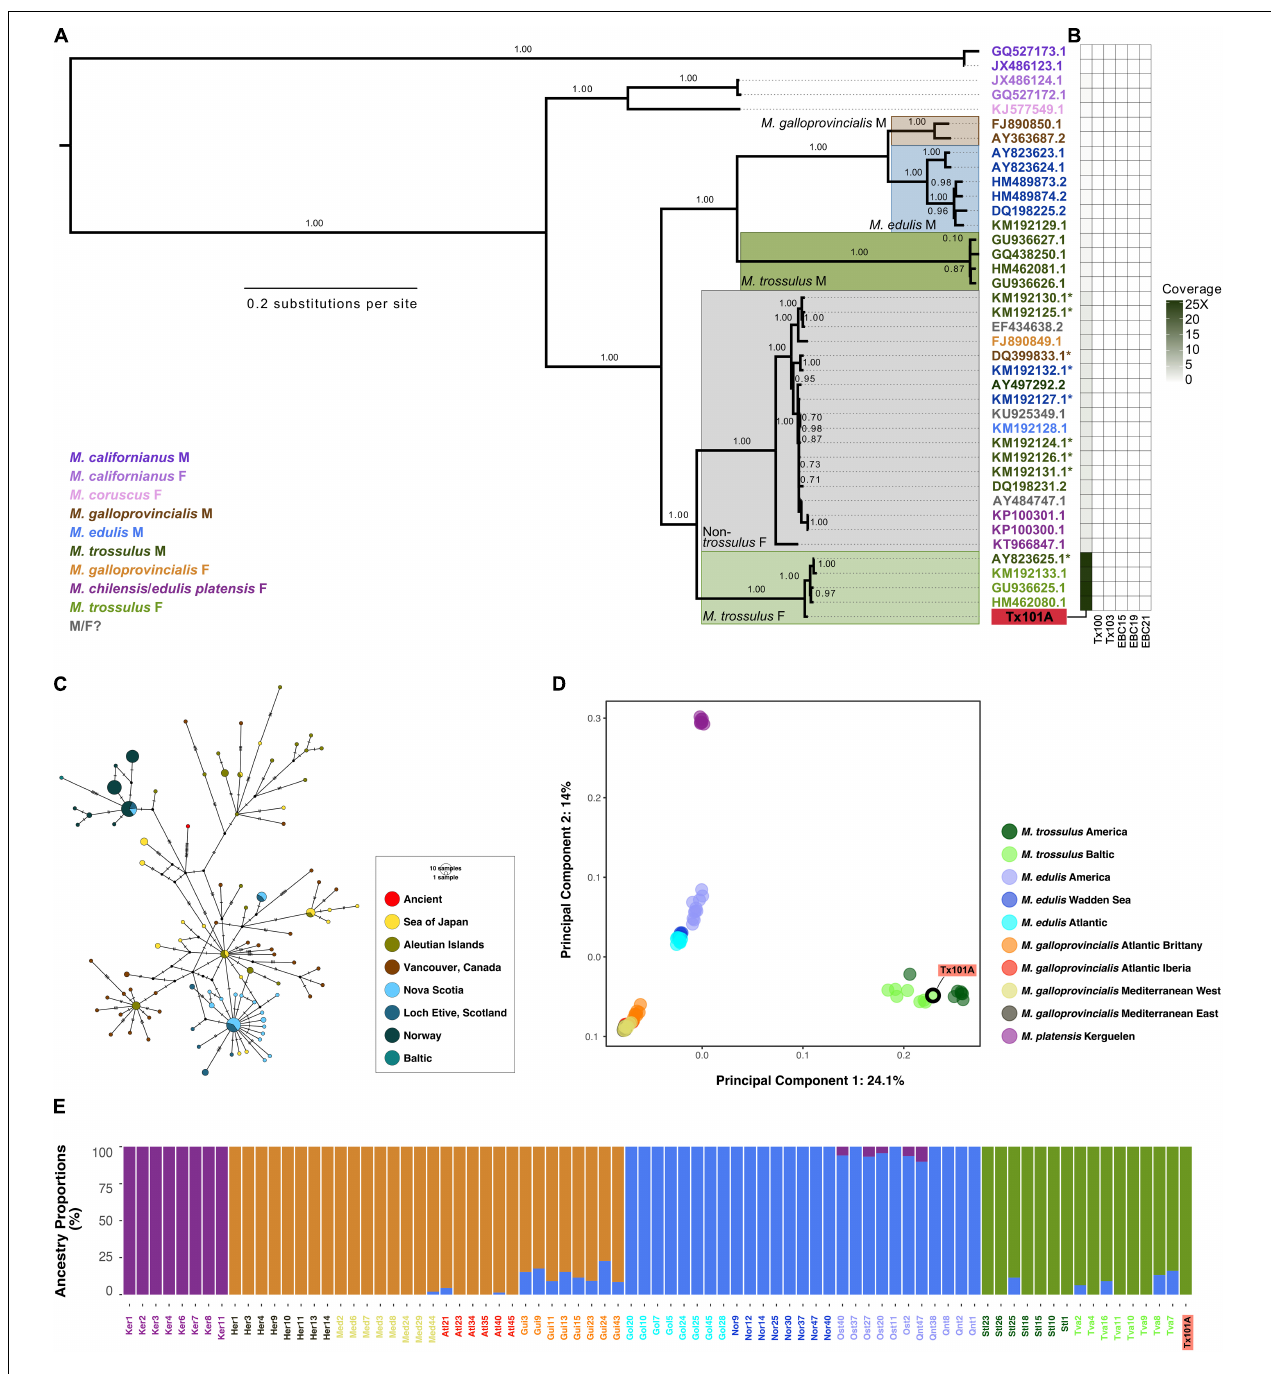
FIGURE 1 | Phylogenetic and population affinities of Tx101A within present-day Mytilus . (A) Maximum likelihood phylogenetic tree built from a concatenated alignment of Mytilus mitochondrial sequences for 12 protein-coding genes, the 12S rRNA gene and 23 tRNAs (total length 14,277 bp). The sex and species of modern individuals were determined based on morphology and nuclear DNA markers. Branch support ≥ 0.70 is shown as Shimodaira-Hasegawa approximate Likelihood Ratio Test. *Recently masculinized mitochondrial genomes. (B) Average depth-of-coverage when mapping against each Mytilus mitochondrial reference genome considering unique high-quality reads ( ≥ 30). (C) Median-Joining network built from a 1,171 bp concatenated alignment of mitochondrial genes ( COX3 , ND2 ) and transfer RNA (Ser, Met) from 187 present-day M. trossulus individuals. (D) Principal Component Analyses of the top two principal components in a dataset comprising 11,882 variable sites (considering transversions only) for 80 individuals. The proportion of the variance explained by each component is indicated for each axis. (E) Ancestry proportions estimated considering four ancestral populations (transversions only). Individual color code is the same as in (D) .